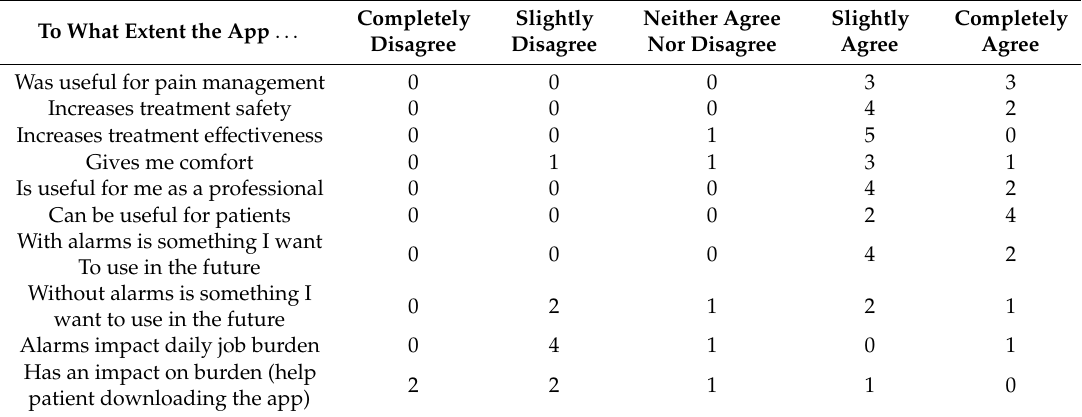
Table 3. Physician opinions about the mHealth